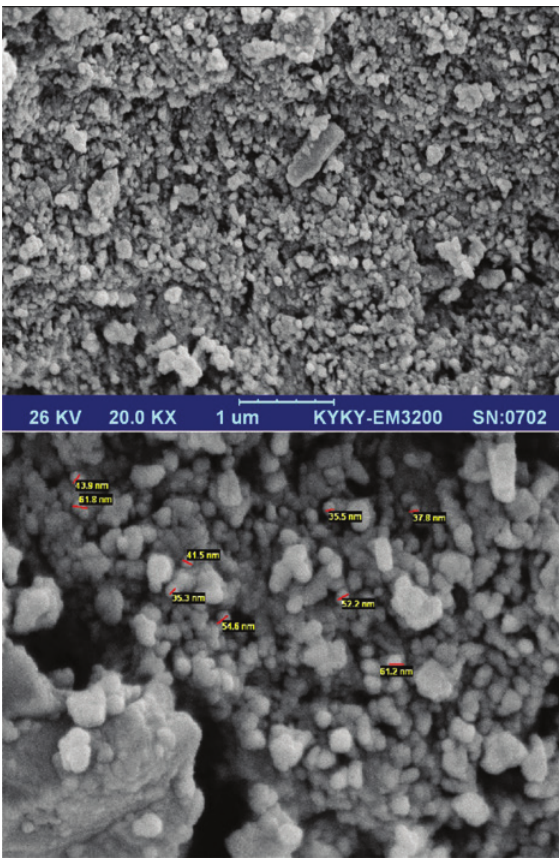
O nanoparticles 12 19